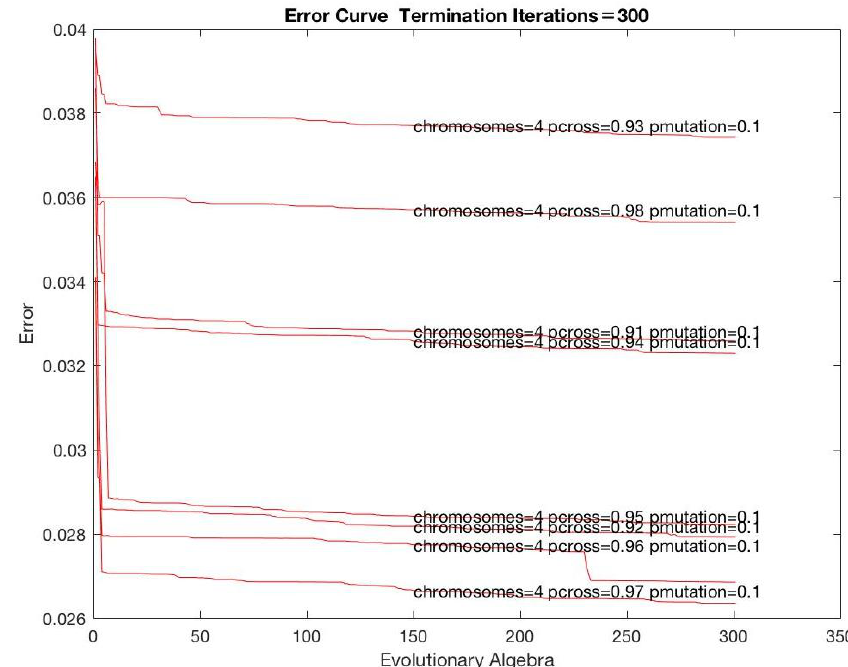
Figure 6. Effect of crossover probabilities on the objective function value.